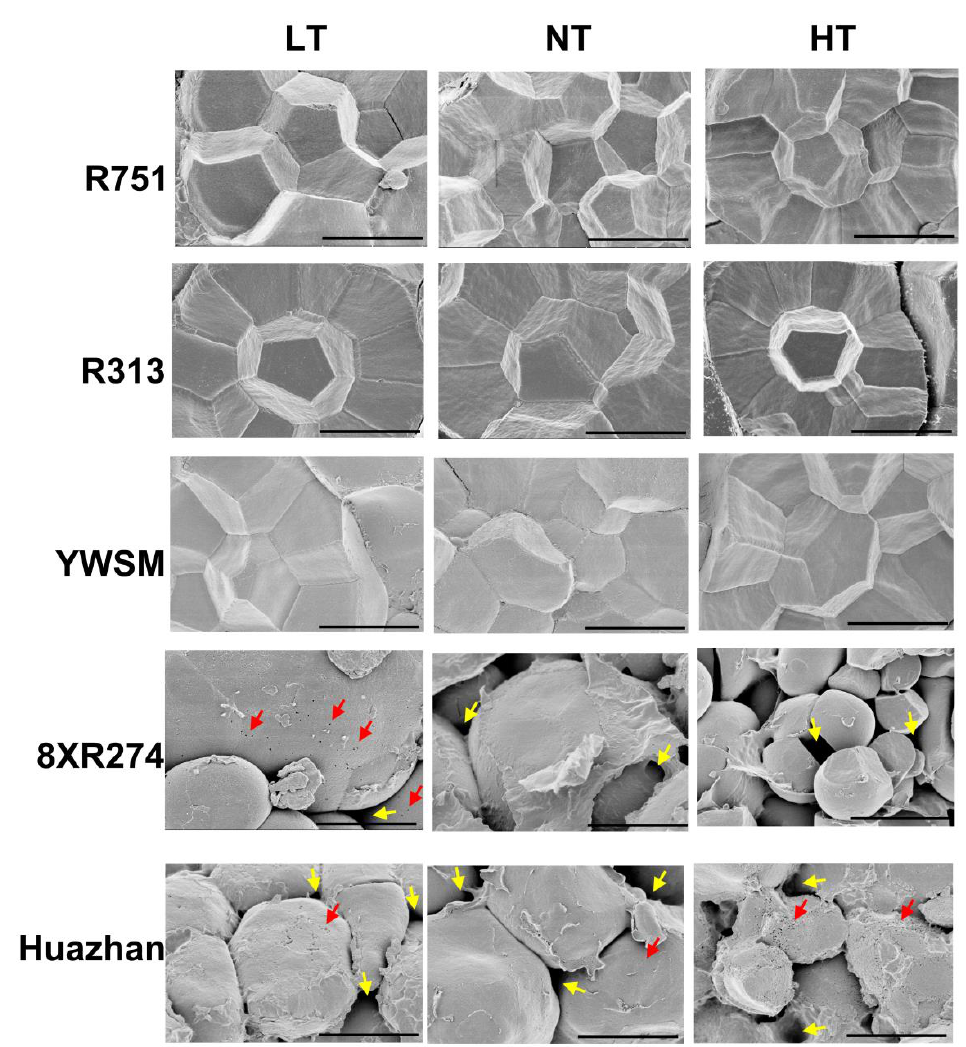
Figure 3. Scanning electron micrographs of starch granules obtained by observing horizontal slices. LT represents low temperature, HT represents high temperature, and NT represents the normal temperature control. Red arrows indicate pits on the surfaces of starch granules. Yellow arrows indicate air spaces in between granules. Bar = 5 μm.